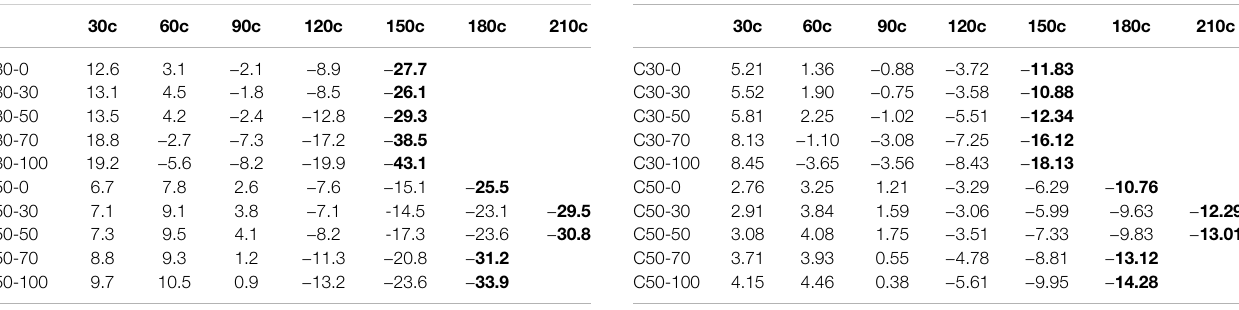
TABLE 6 | Relative compressive strength factor of concrete after sulfate wetting – drying cycles.